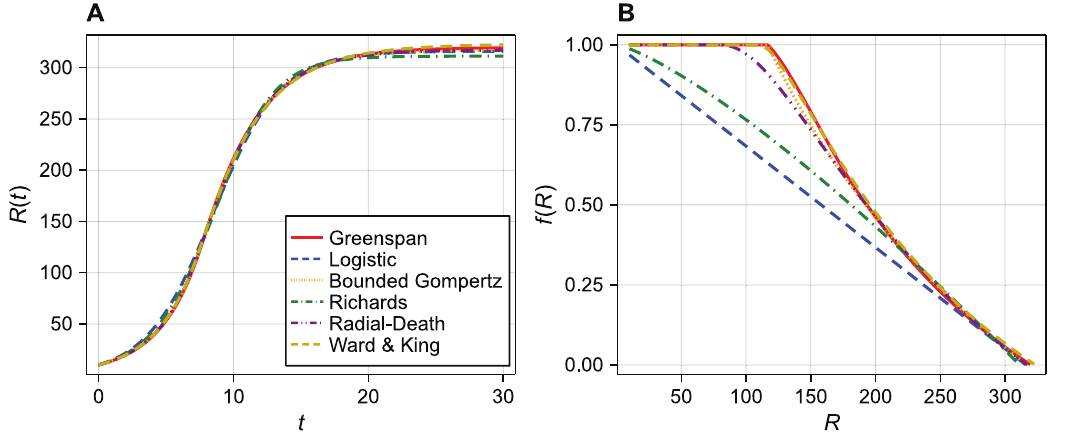
Fig 4. Model solutions and crowding functions. (A) We show the outer radius, R ( t ), predicted by each model using parameters chosen to match the solution of the Greenspan model. (B) The corresponding crowding function for each model when expressed as a generalised logistic growth equation (Eq